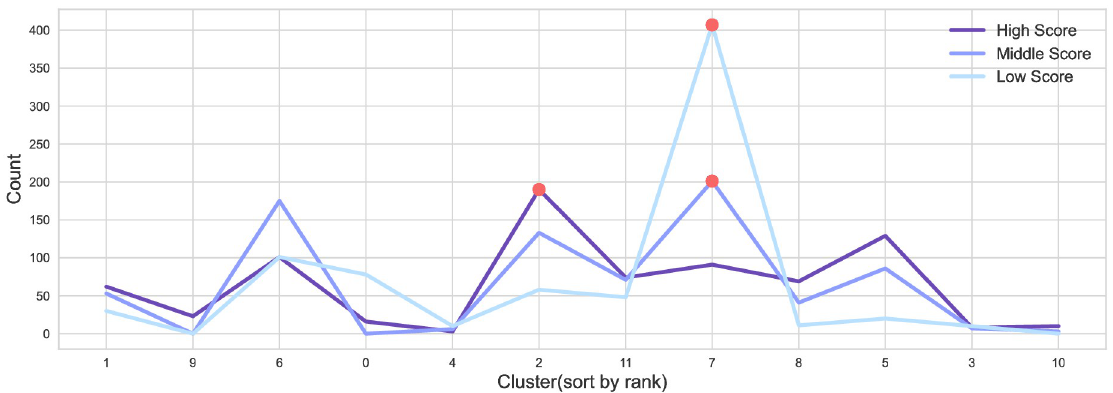
Fig 3. Cluster distribution by actor label according to the score of success.